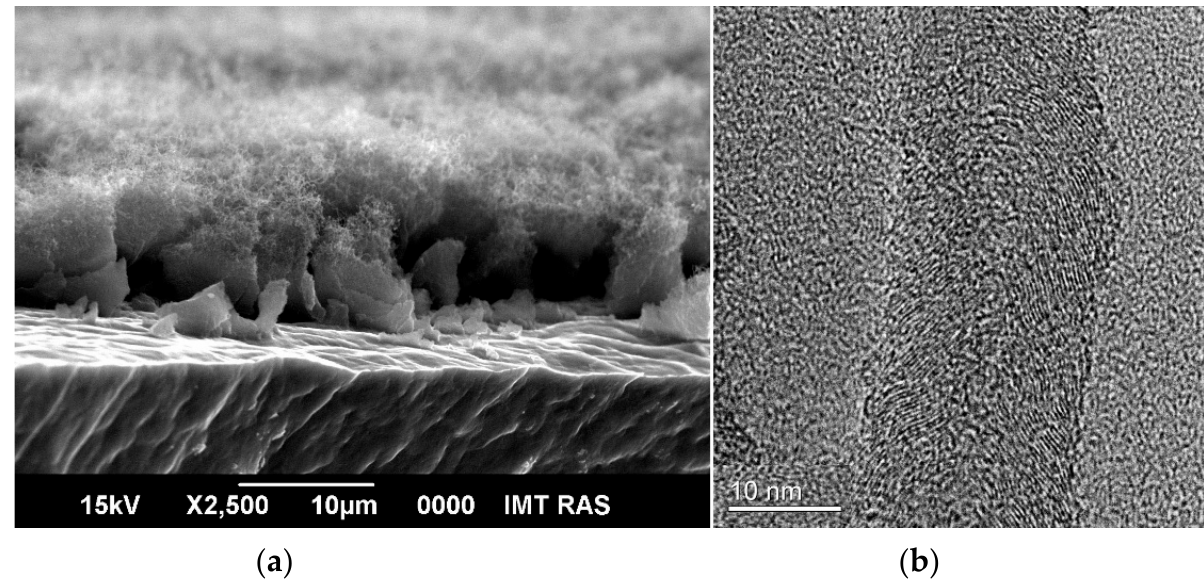
Figure 1. ( a ) Scanning electron micrographs of MWCNT/Al foil: cross-section; ( b ) transmission electron micrograph of individual MWCNT.